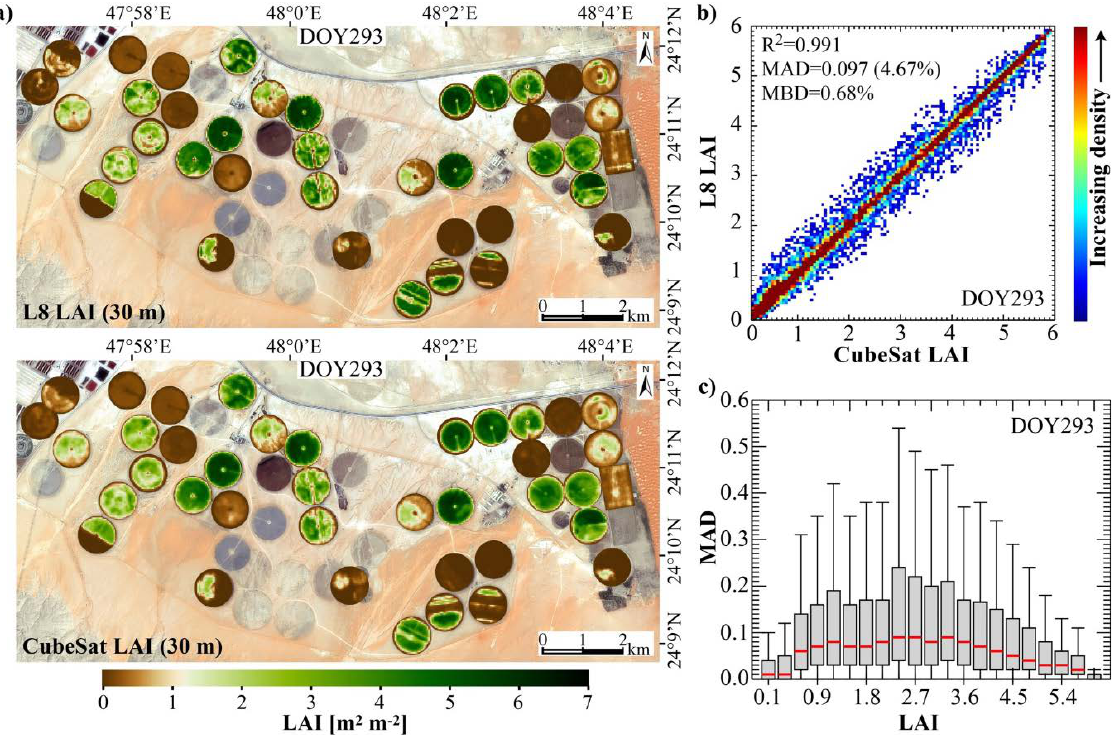
Figure 5. ( a ) Maps of 30 m resolution LAI based on Landsat 8 (L8) ( top ) and CubeSat ( bottom ) data acquired on day of year (DOY) 293. CubeSat LAI was derived via random forest machine-learning using L8 LAI as reference (see Section 2.4.4). ( b ) Density scatter plot intercomparing CubeSat and L8-based LAI on DOY 293. Statistical performance metrics are indicated on the plot and include the coefficient of determination ( R 2 ), the mean absolute difference (MAD), and the relative mean bias difference (rMBD). ( c ) Box-and-whisker plot that displays the minimum, lower quartile, median, upper quartile, and maximum of the MADs between CubeSat and L8 as a function of LAI. See Table 1 for the definitions of MAD and rMBD.